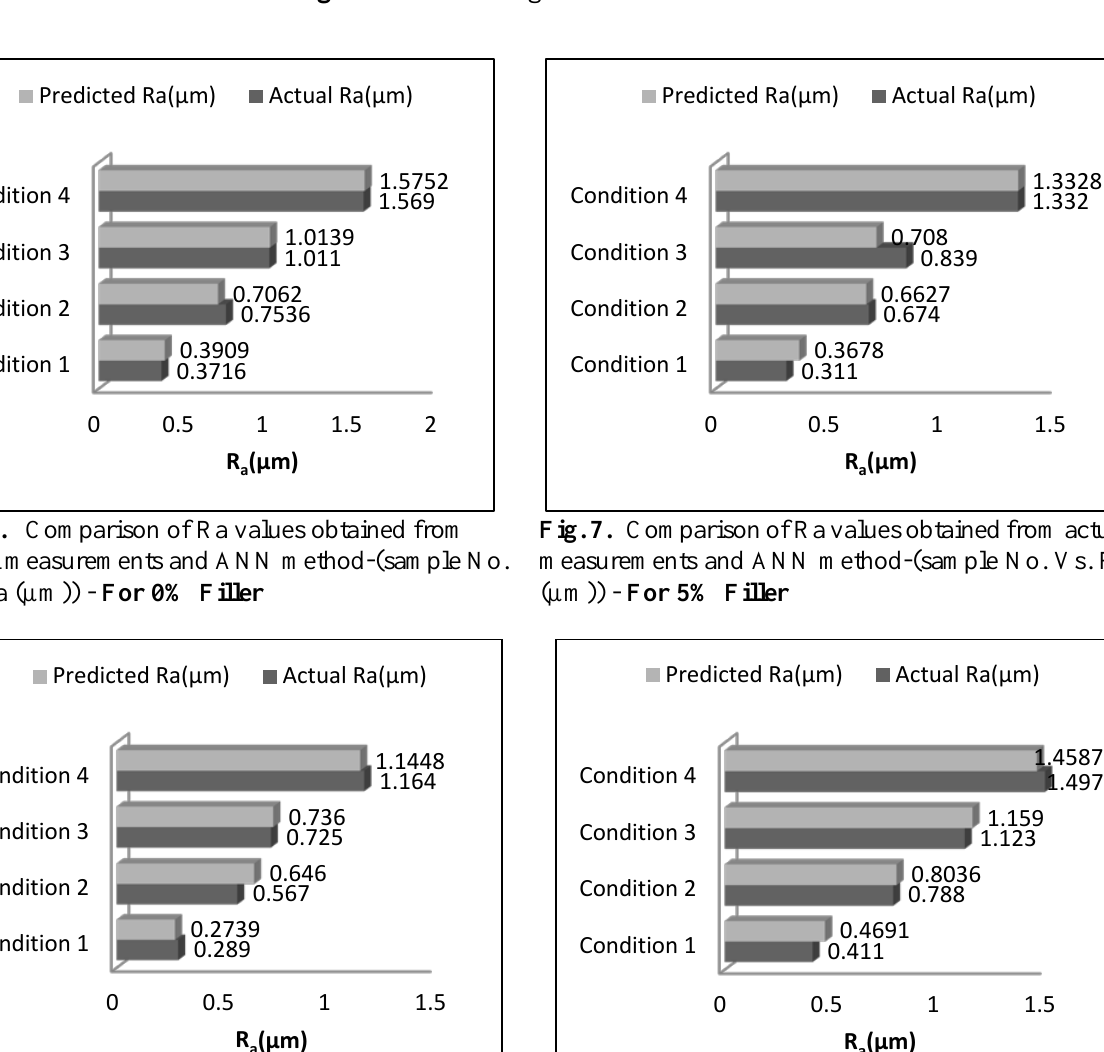
Fig. 5. Error Histogram results simulation